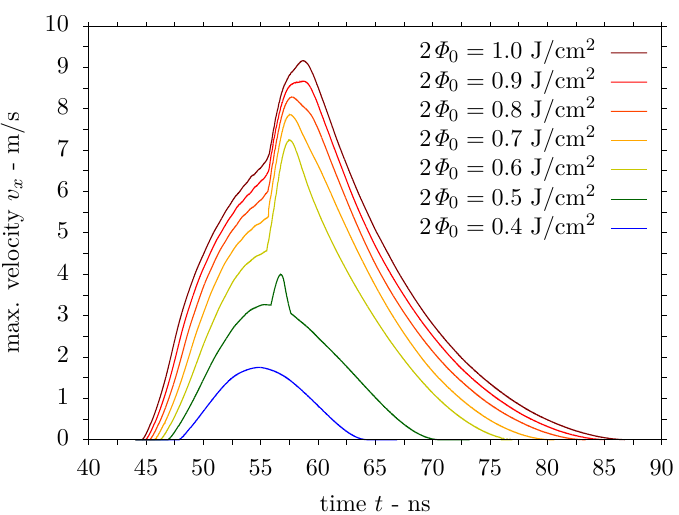
Figure 5. Maximum horizontal velocity magnitude below the melt pool surface as determined by the SPH model of DLIP considering AISI 304 stainless steel substrate and different laser